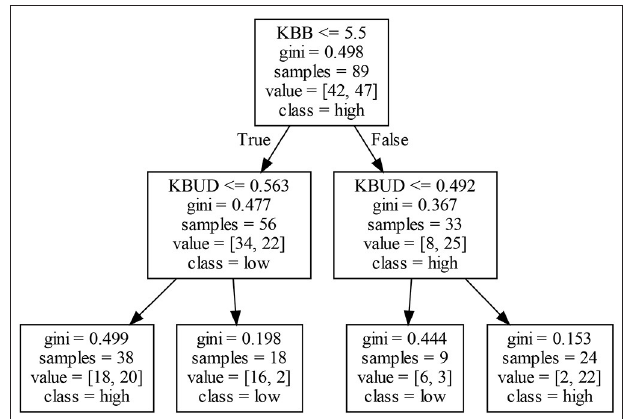
FIGURE 3 | Decision tree for exploratory innovation performance (EIP1) in Cluster